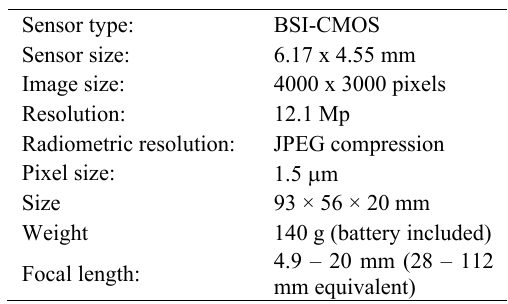
Table 4. Technical specifications of the compact camera, Canon IXUS 115 HS.